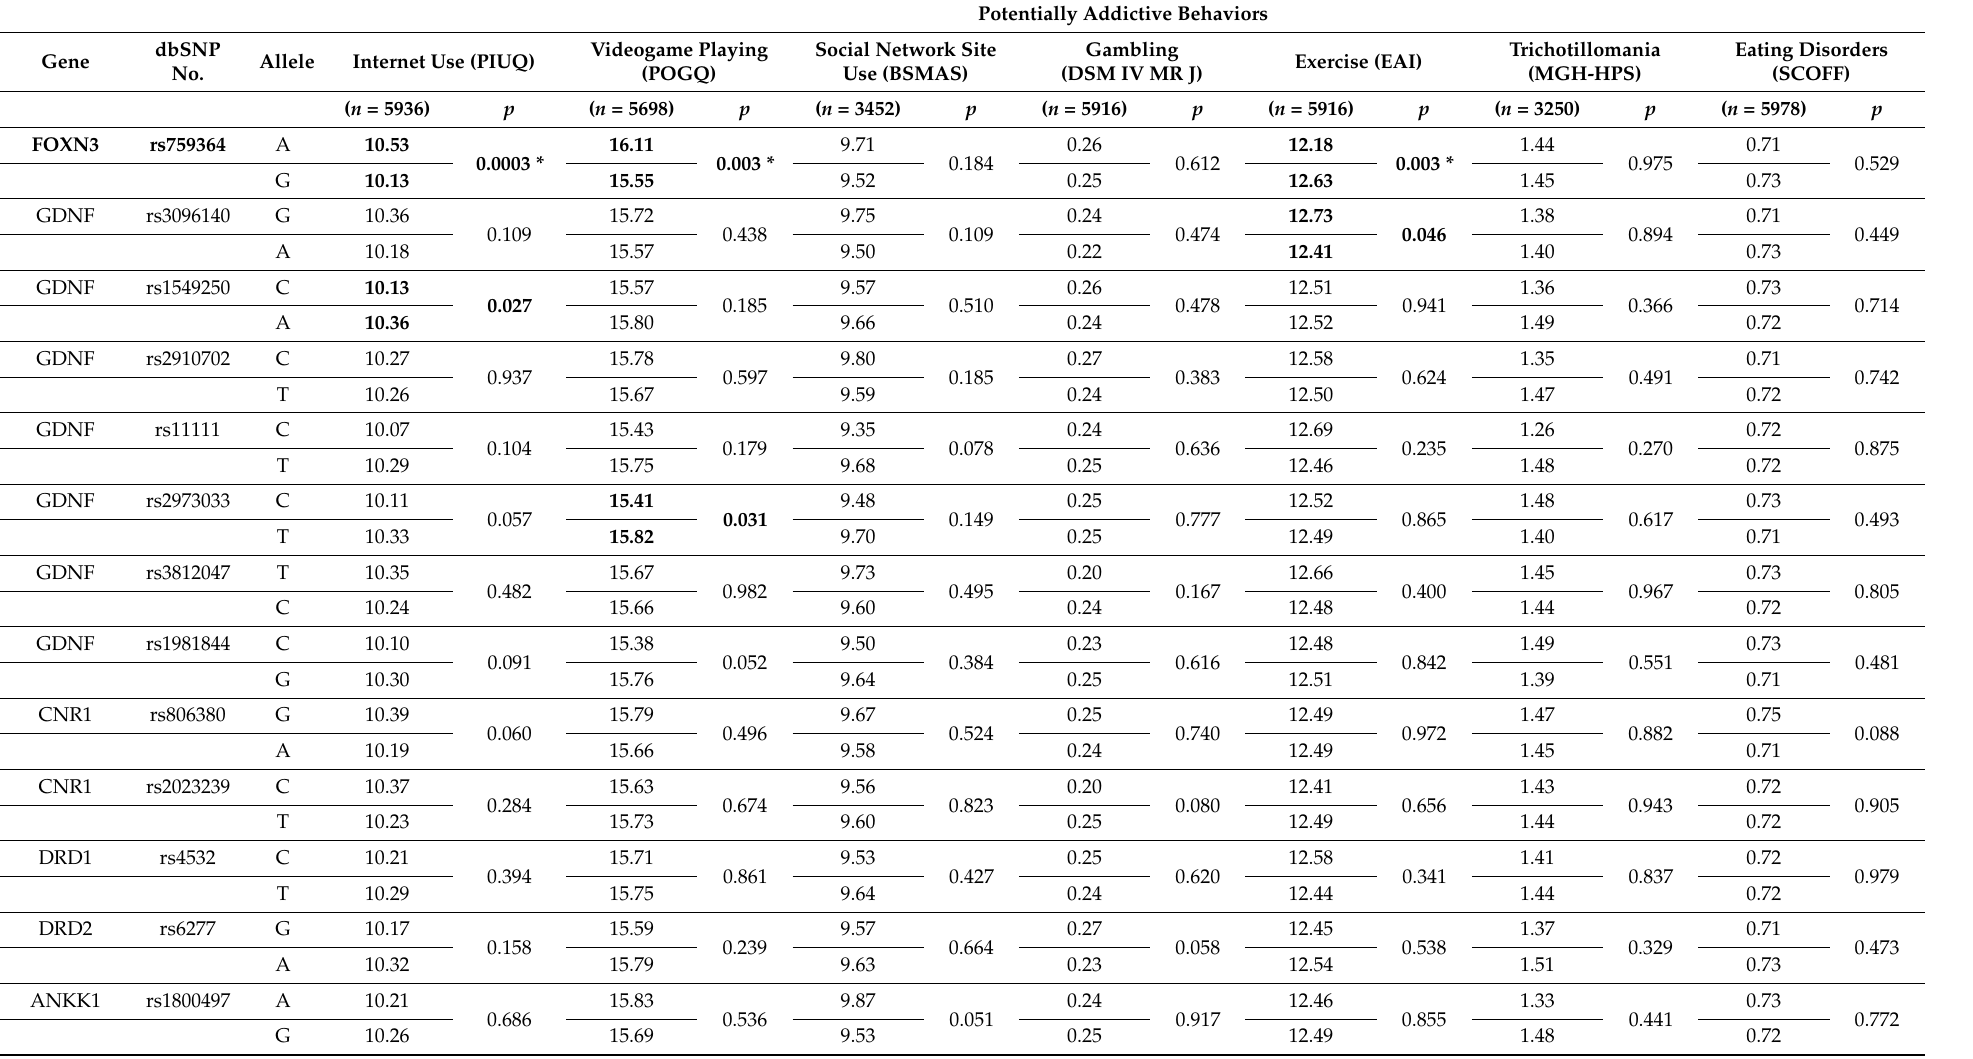
Table 2. Genetic association analysis results regarding addiction candidate genes and potentially addictive